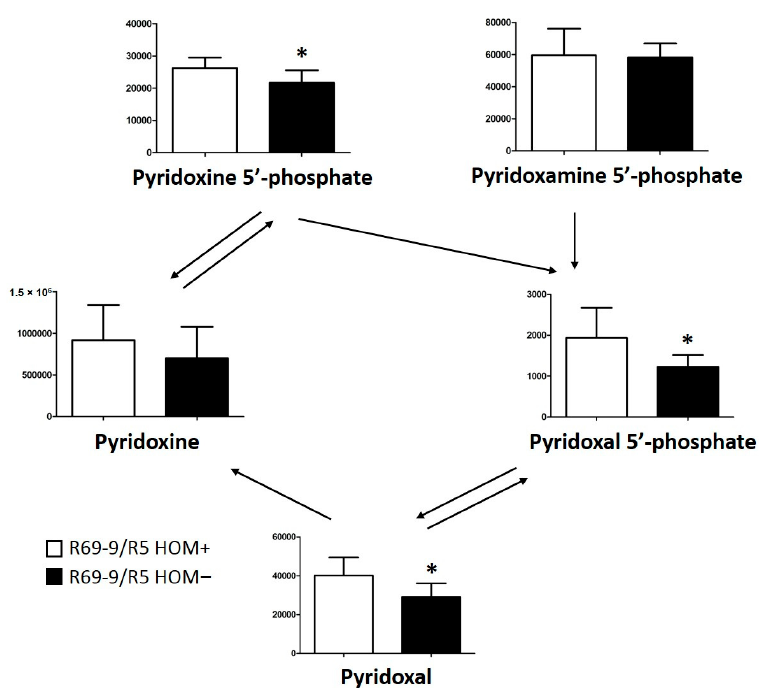
Figure 8. Significant changes in accumulation of intermediates of vitamin B 6 in rachis tissue of the resistant Fhb7E (HOM+) and susceptible (HOM − ) lines at 4 dpi ( Fg ). Values on y-axes always indicate Peak intensity of a given metabolite, while bars on histograms represent standard deviations of means. For each metabolite, comparison between the HOM+ and HOM − genotypes was analysed using Student’s t -test; * indicates p -value at the <0.05 level of significance. Arrows between metabolites indicate a direct transforming relationship. Double arrows denote a reversible reaction.